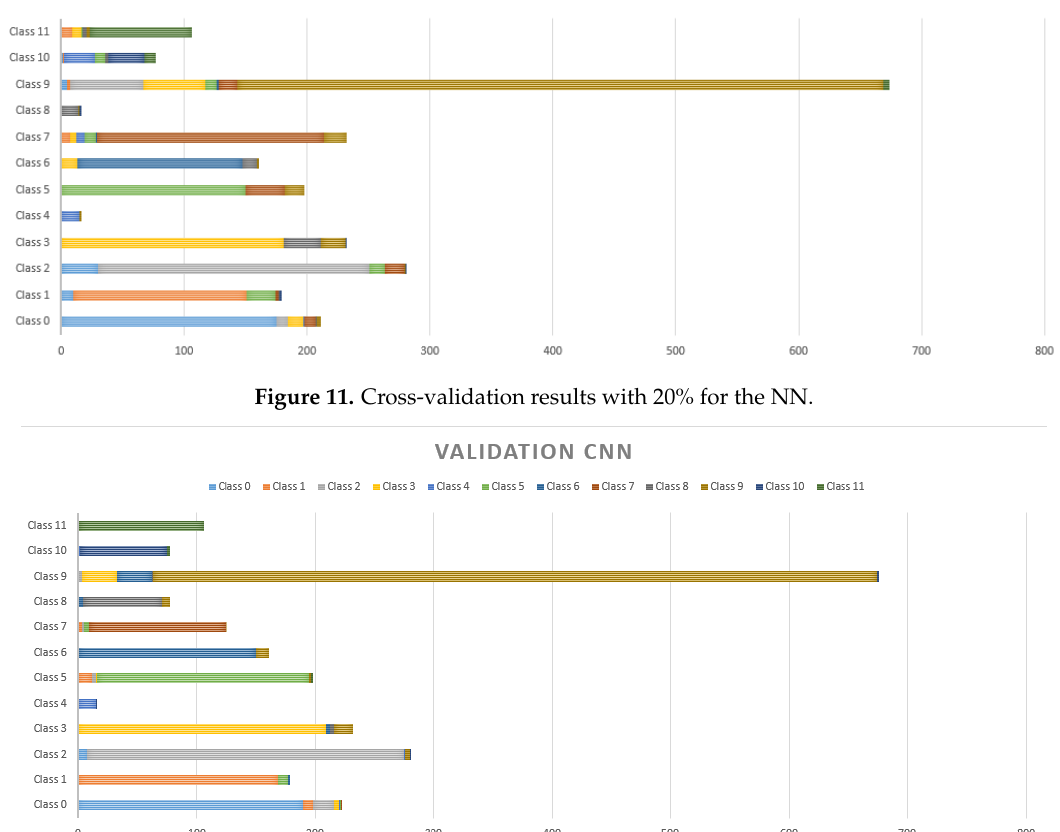
Figure 12. Cross-validation results with 20% for the CNN.